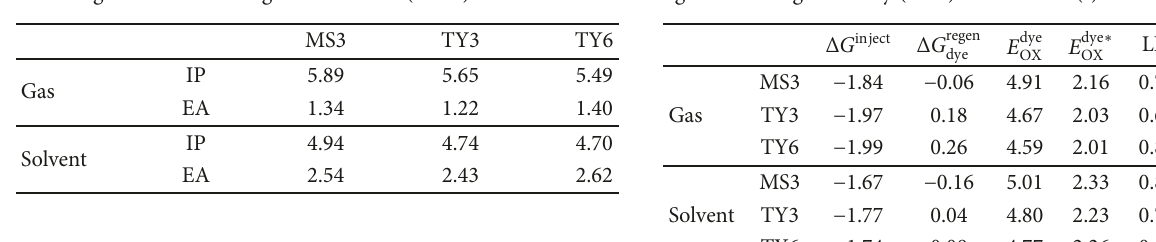
Figure 5: (a) The UV – Vis absorption spectra in gas and (b) the UV – Vis absorption spectra in solvent. Table 4: Ionization potentials (IP) and electron a ffi nities (EA) of Table 6: The electron injection and regeneration free energy, the three original molecules in gas and solvent (in eV). light harvesting e ffi ciency ( LHE ) and lifetime ( t